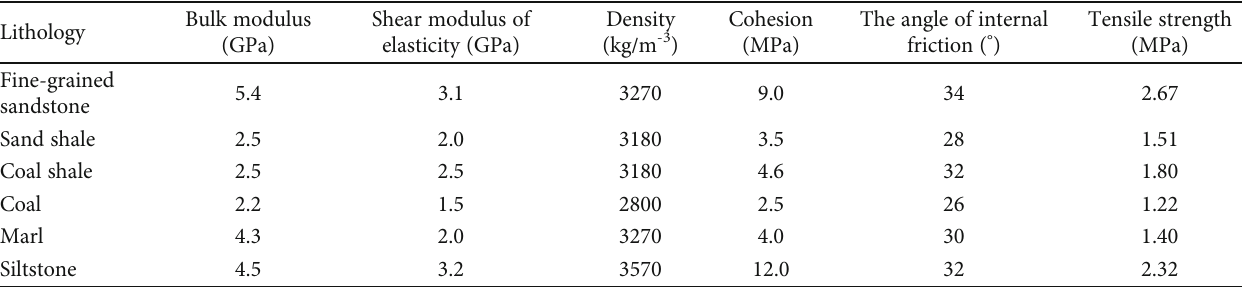
Figure 3: Numerical calculation model. Table 1: Rock mechanics parameters of the computation